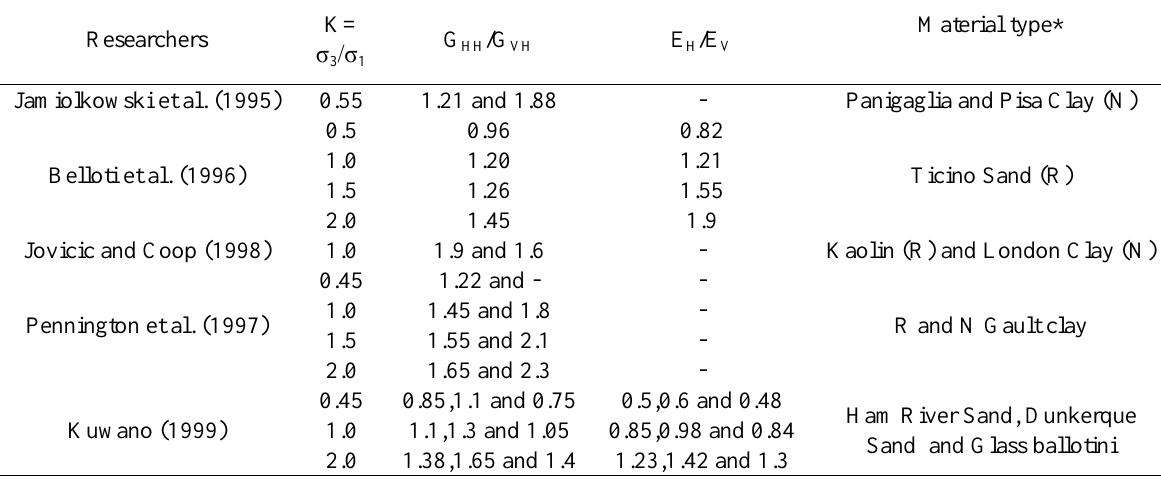
Table 1. Stiffness anisotropy of different